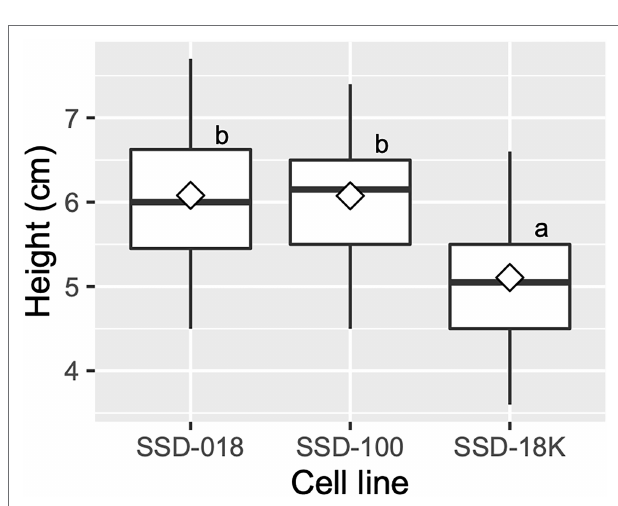
FIGURE 8 | Growth of acclimatized somatic plants of pollen-free sugi ( C. japonica ) 3 months after their transfer into plant plugs. The open diamond in the boxplot represents the mean. The different letters indicate significant differences among the cell lines ( p < 0.05, pairwise comparison with BH